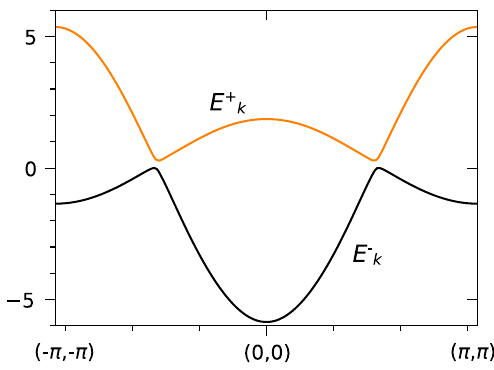
FIG. 7. Band structure of the 2D PAM for V ¼ 0 . 3 and V 0 ¼ 0 . 75